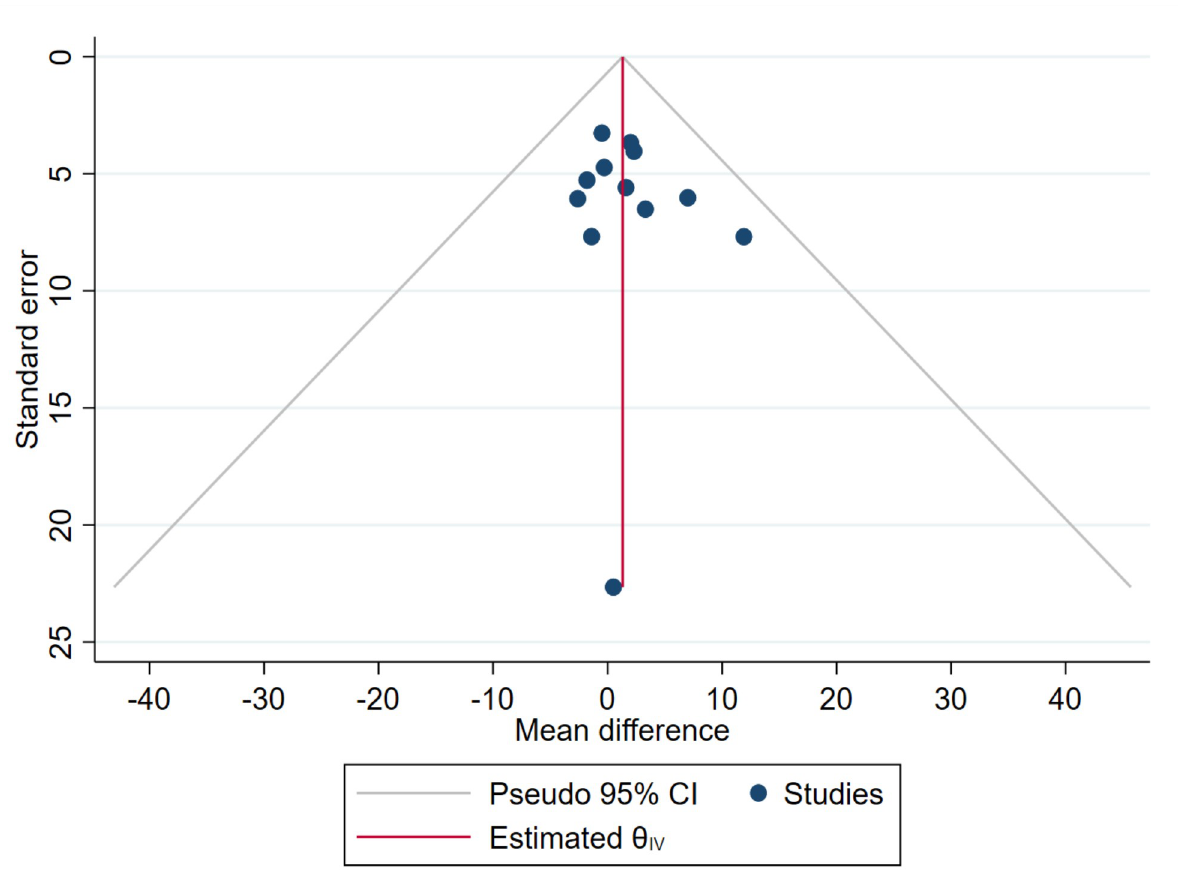
Fig 7. Funnel plot of daily insulin dose (U/24 hours) during CIPII treatment compared to that during control treatment (CSII). The funnel plot includes diagonal lines representing expected distribution of studies in the absence of heterogeneity (95% of the studies should lie within these diagonal lines). The lines are not strict 95% confidence interval, therefore, referred as ‘pseudo 95%